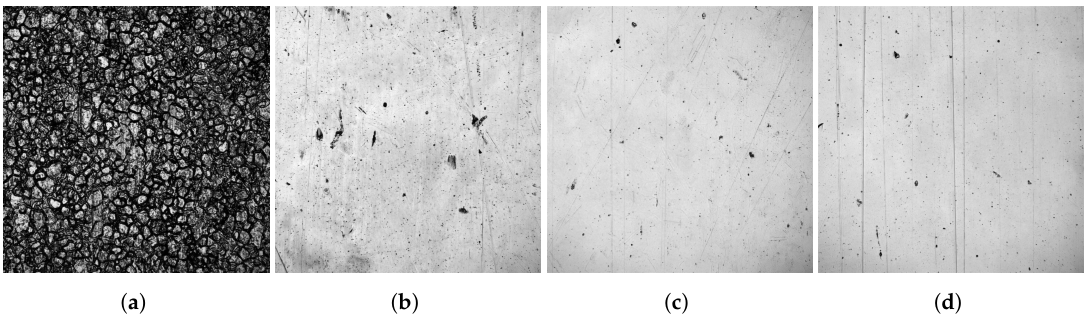
Figure 5. CLSM images of unpolished and plasma polished surfaces (scan area: 258µm × 250µm): ( a ) unpolished surface ( Sa = 0.726µm); ( b ) plasma polished surface after t ept = 13.33s ( Sa = 0.040µm); ( c ) plasma polished surface after t ept = 26.66s ( Sa = 0.024µm); ( d ) plasma polished surface after t ept = 40.00s ( Sa = 0.023µm).